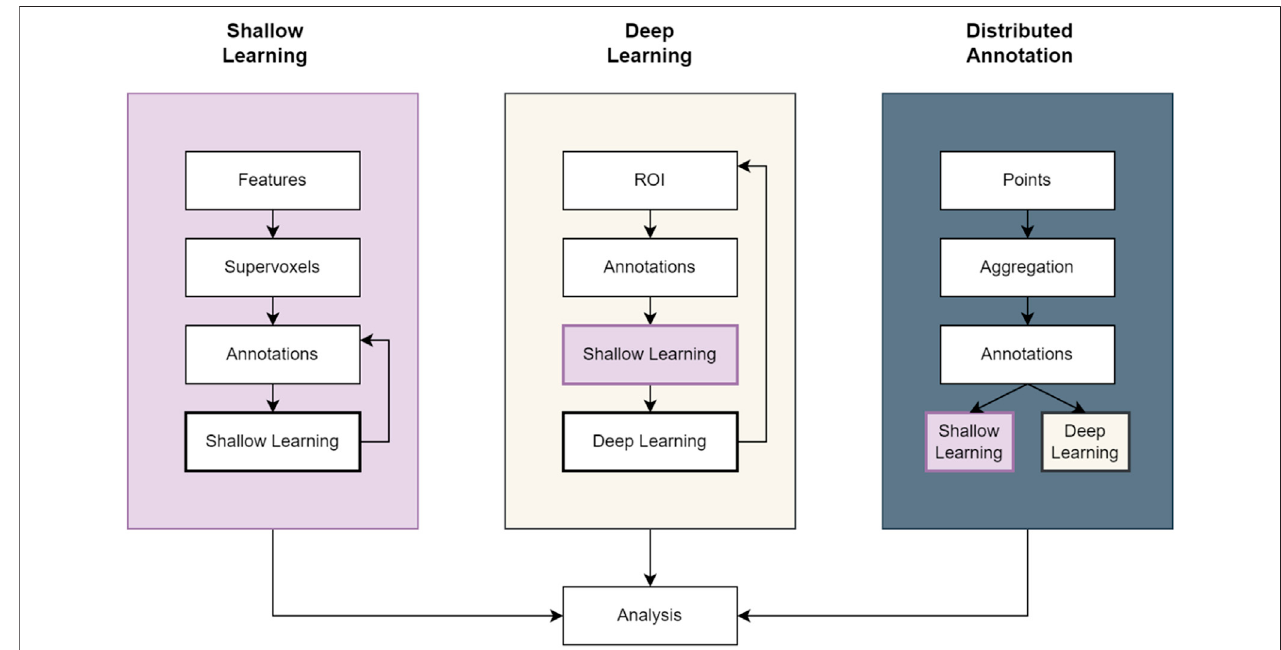
FIGURE 1 | Example work fl ow pipelines in SuRVoS2. The Shallow Learning pipeline is the same as previously available in SuRVoS using an iterative painting and predictingcycletoproduceanoutputsegmentation.TheDeepLearningpipelineincorporatestheShallowLearningpipelinetoquicklygenerateexpertsegmentationson a region of interest (ROI) which can subsequently be used to train a deep learning model for application to the full volume. And fi nally, the Distributed Annotation pipeline uses geometric data alongside either the Shallow Learning or Deep Learning pipelines to segment objects marked by 3D points.